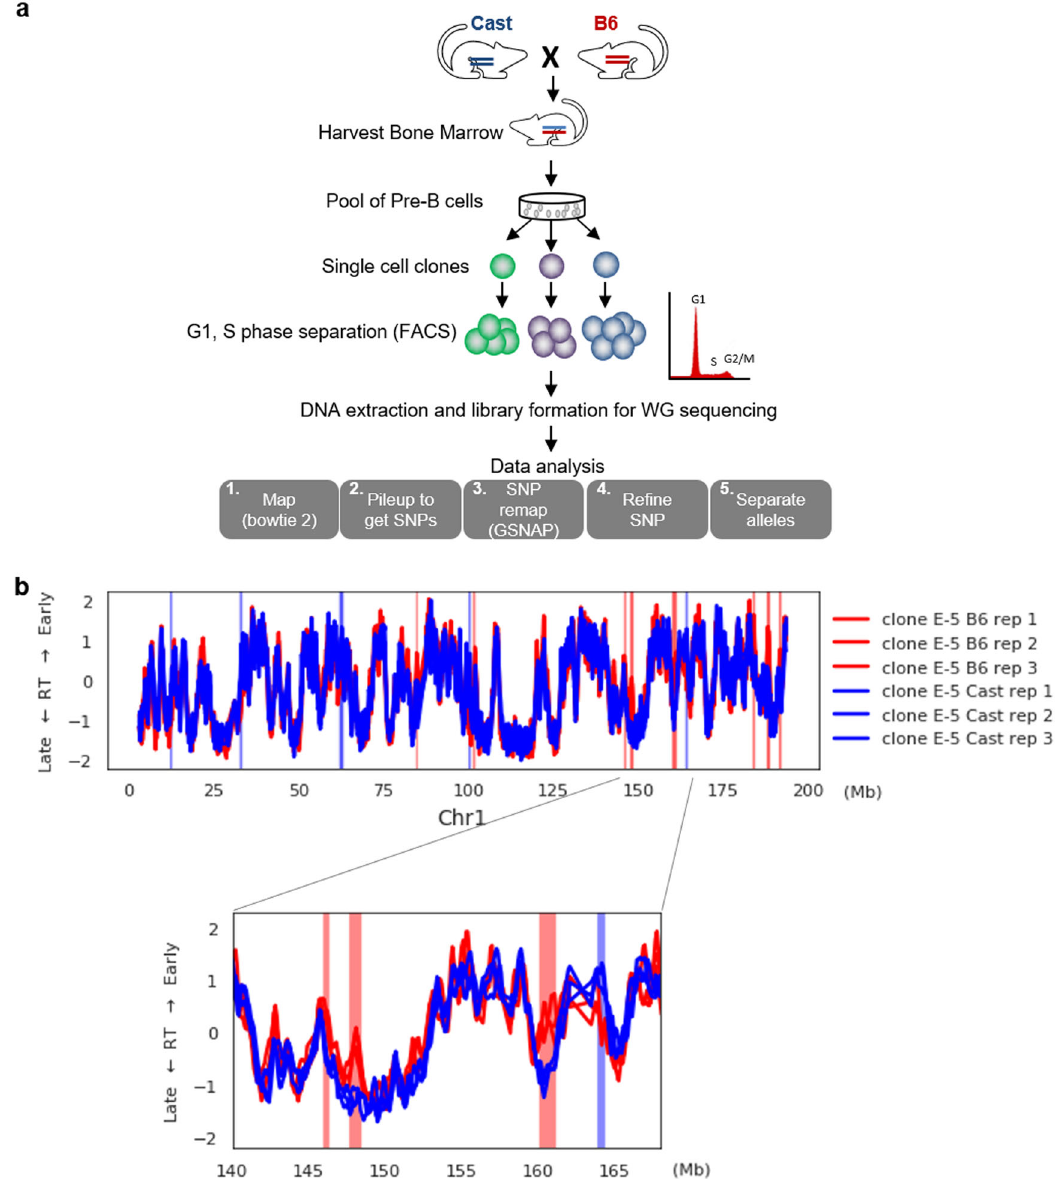
Fig. 1 Whole-genome allele-speci fi c replication-timing analysis. a Experimental design. b Replication timing (RT) of Cast (blue) and B6 (red) alleles (in clone E-5) on chromosome (Chr 1) for three individual replicates, with a magni fi ed view of an ~25 Mb region. Relative replication time in S phase is on a scale from − 2 (very late) to + 2 (very early). Asynchronous regions are indicated by a red (B6 early) or blue (Cast early)